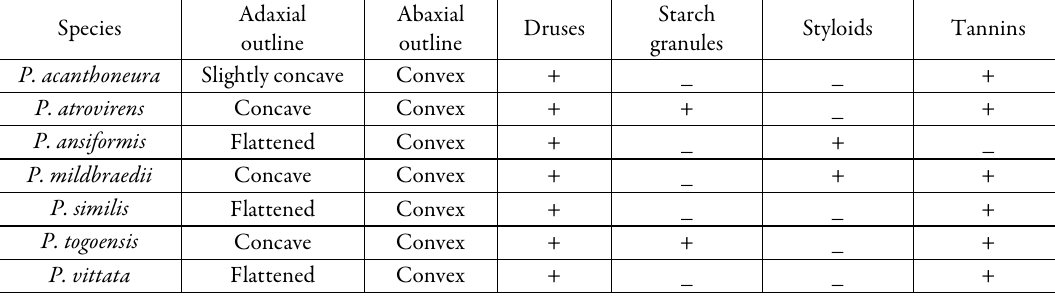
Table 2. Summary of the features in median regions of stipes of the Pteris species